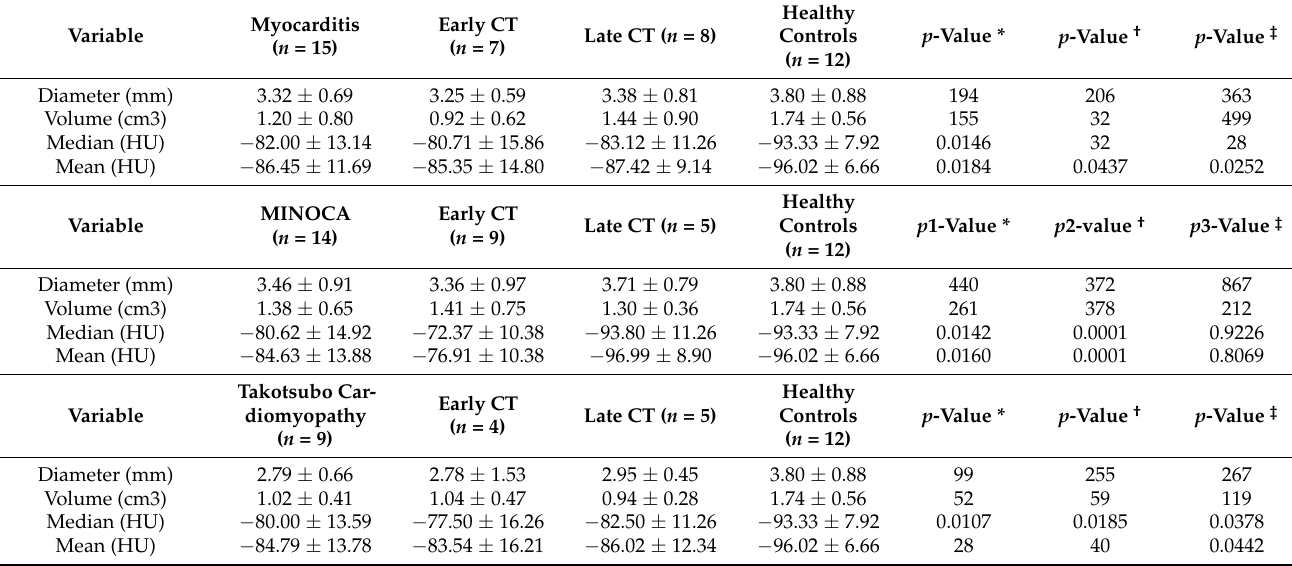
Table 4. All diseases vs. early detection vs. late detection.